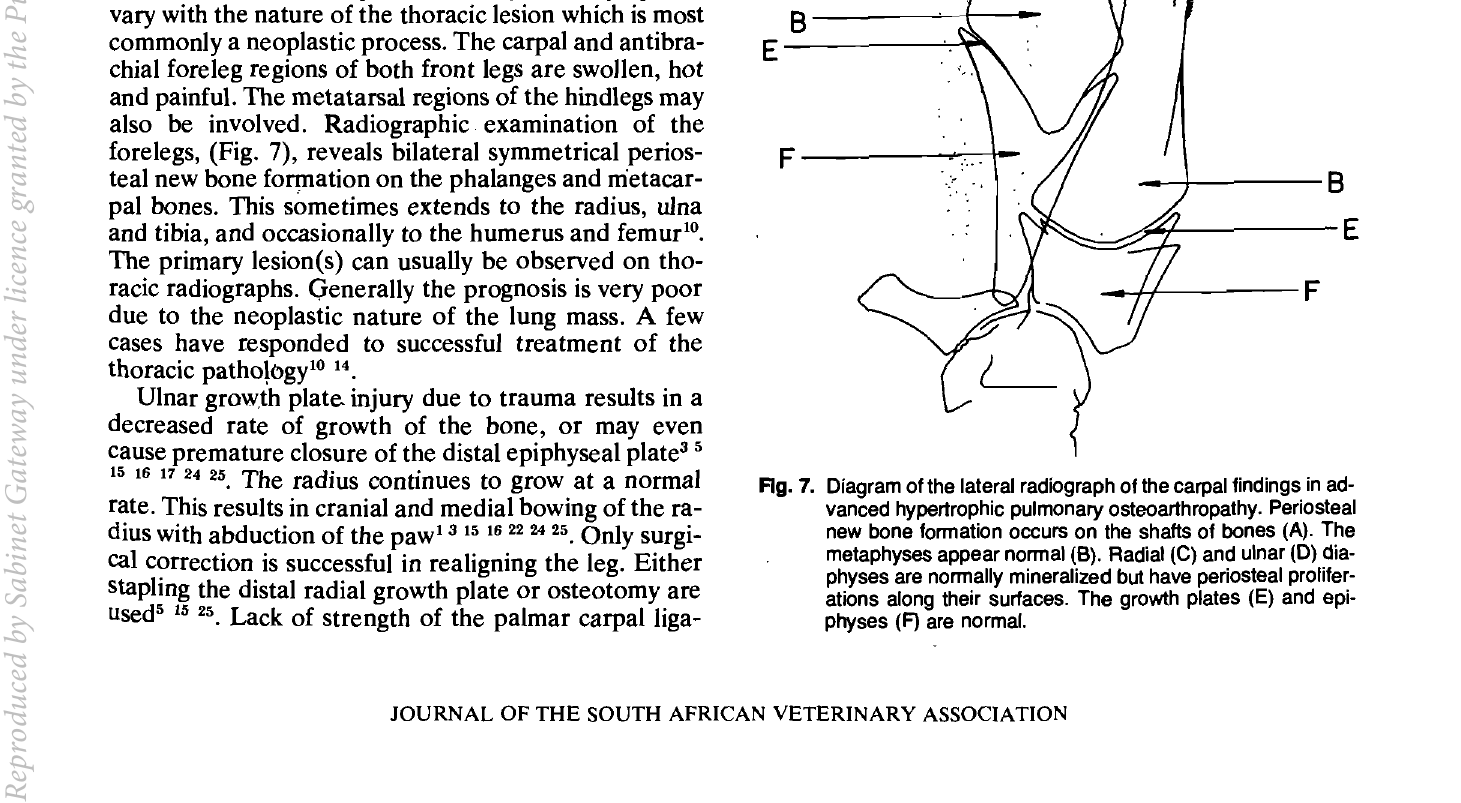
Fig. 6. Diagram of the lateral radiograph of the carpal findings in rickets. Radial (A) and ulnar (8) metaphyses are radiolucent and markedly enlarged, especially adjacent to the epiphy seal lines. The radial diaphyses is inadequately mineralized and is bowed cranialw~rd (C). The diaphysis of the ulna is radiolucent (D). The growth plates are widened and have ir regular metaphyseal and epiphyseal borders (E). The demi neralized epiphyses appear radiolucent (F).